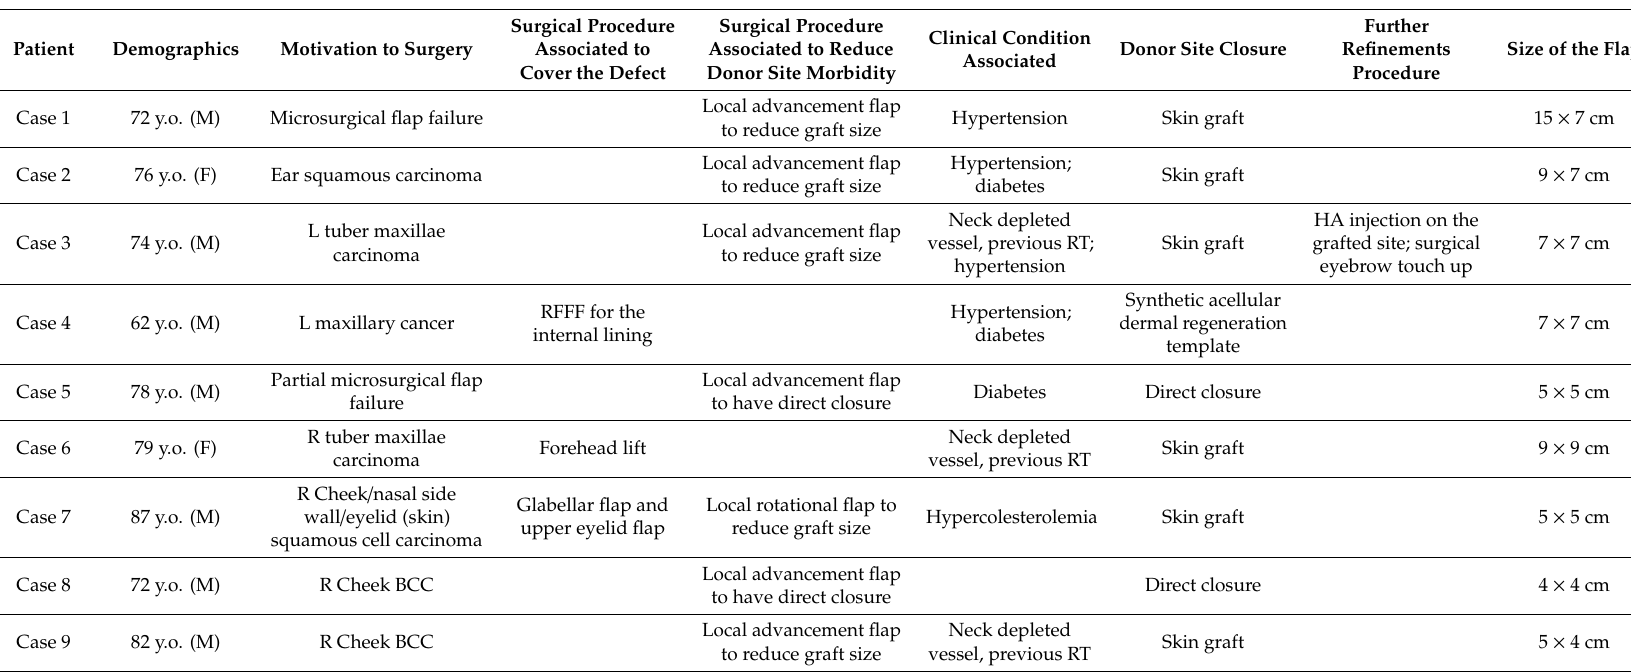
Table 1. Patient’s demographic data, motivation for surgery, donor site closure, and the size of STAP flap used. BCC = Basal Cell Carcinoma; HA = hyaluronic acid; RFFF = Radial Free Forearm